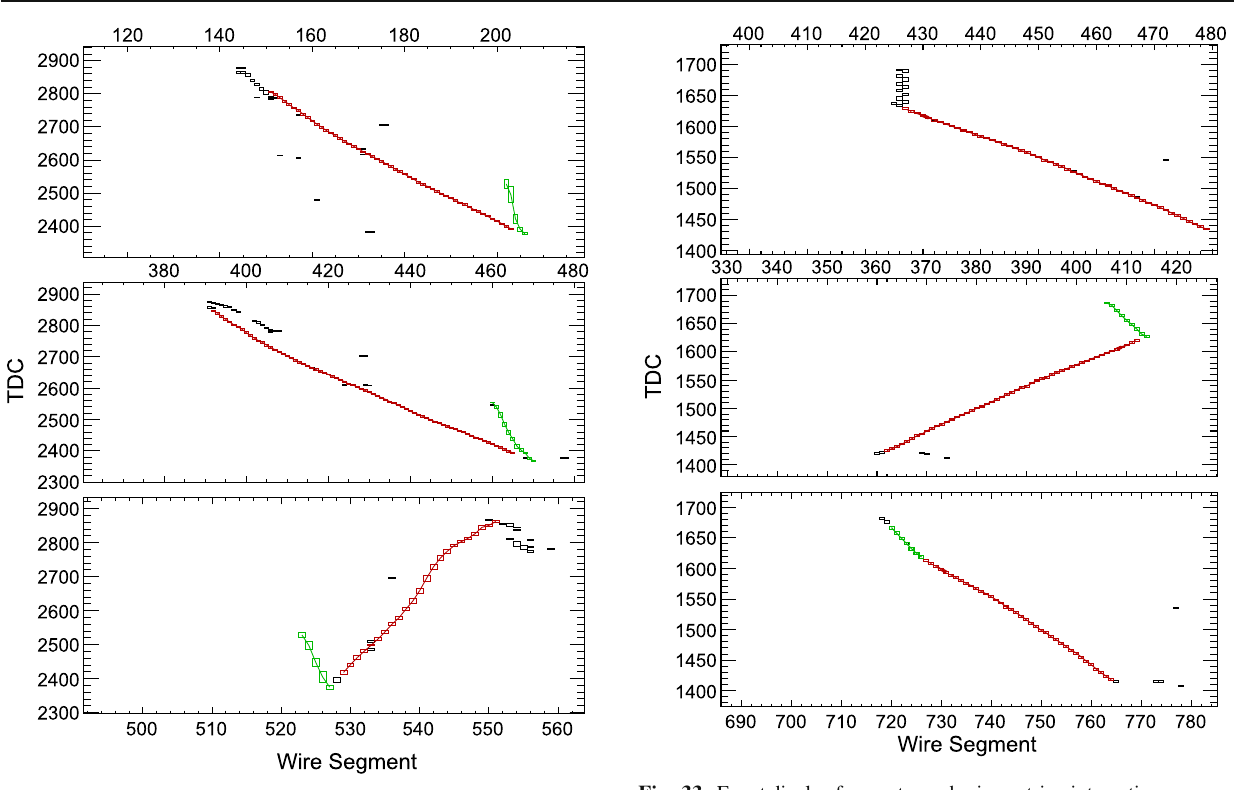
Fig. 32 Event display for an easily recognizable p → K + ν signal event. The vertical axis is TDC value, and the horizontal axis is wire number.Thebottomviewisinductionplaneone,themiddleisinduction plane two, and the top is the collection plane. Hits associated with the reconstructed muon track are shown in red, and hits associated with the reconstructed kaon track are shown in green. Hits from the decay electron can be seen at the end of the muon track